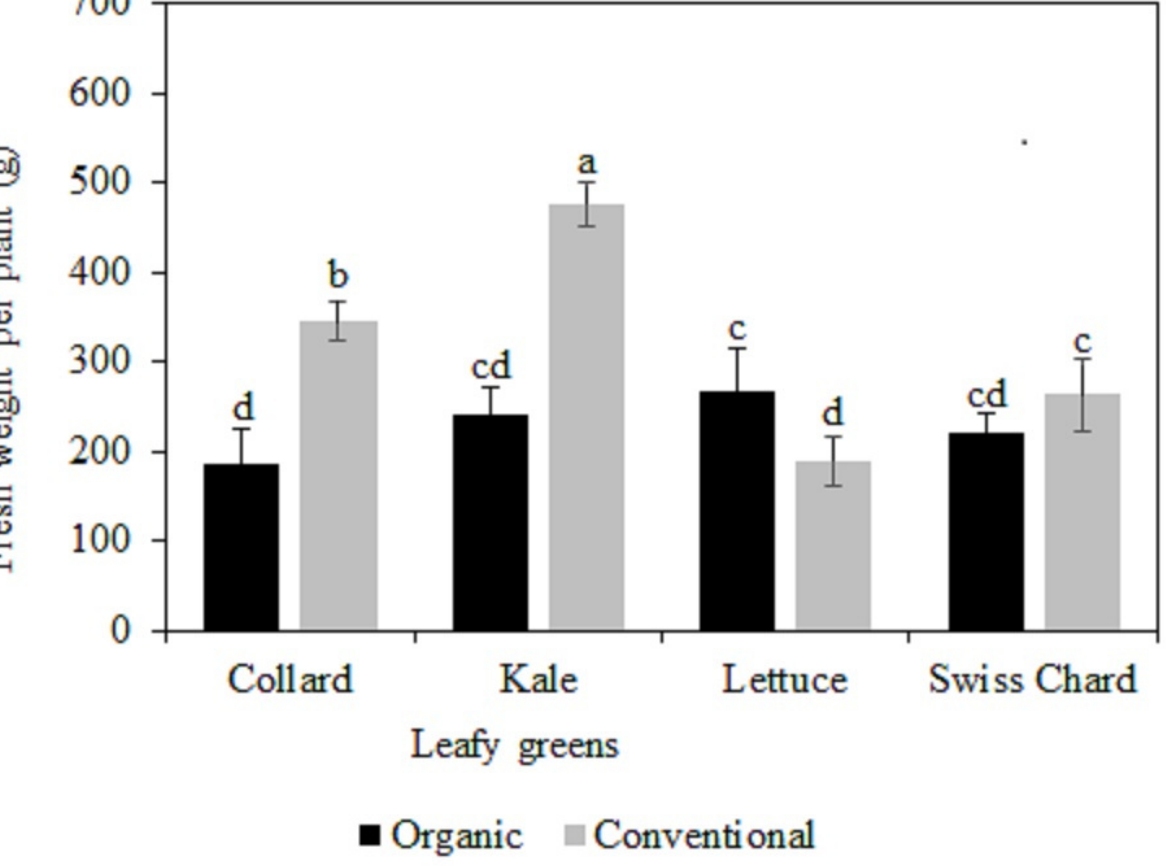
Figure 1. Mean ( ± standard error) of fresh weight of leafy greens (collard, kale, lettuce, swiss chard) grown under two production systems (organic and conventional) in two years (2018 and 2020).